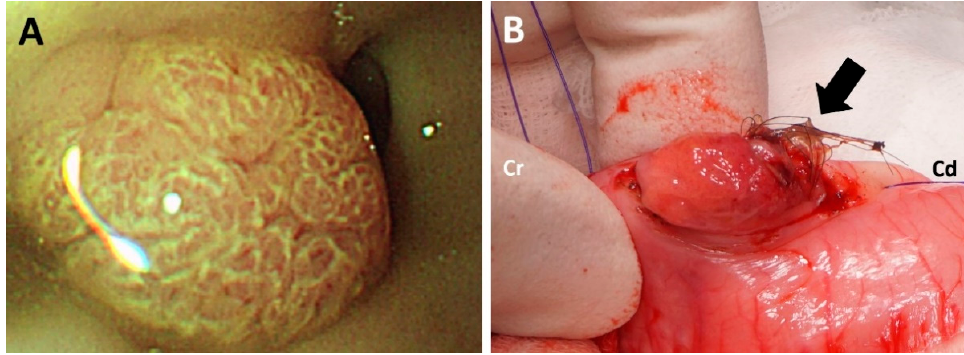
Figure 3. Gross appearance of the cranial surface of the mass during endoscopy ( A ). A lump of hair firmly attached to the ulcerated surface was identified at the caudal side of the mass ( B ).